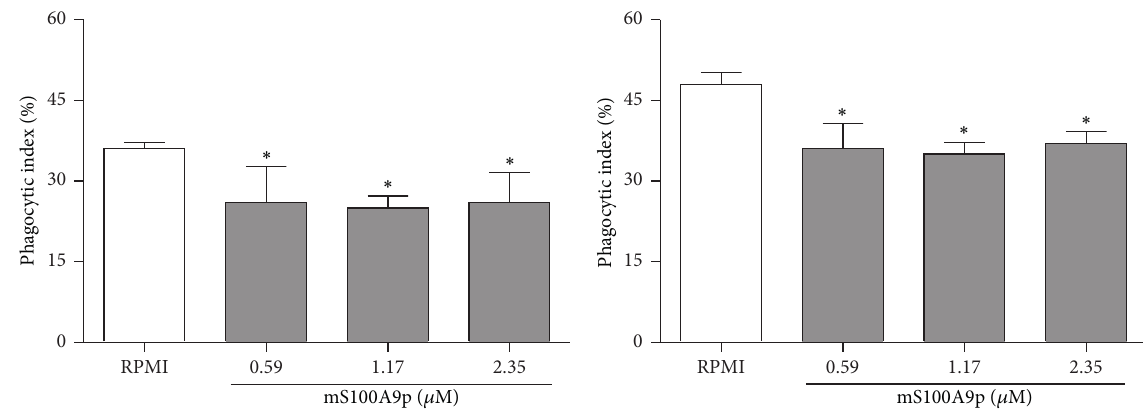
Figure 3: Phagocytosis assays by bone marrow-derived macrophages (BMDM 𝜙 ), cocultivated with B-1 cells, treated with mS100A9p. BMDM 𝜙 adhered to coverslips (1 × 10 5 cells/well) were incubated in the presence of B-1 cells (1 × 10 5 cells/well) concomitant with mS100A9p (0.59; 1.17; or 2.35 𝜇 M in RPMI-1640 medium), for 1h at 37 ∘ C in 5% CO 2 . Coculture assays were evaluated with (a) or without (b) direct contact of these two cell populations, using transwell chambers. Experimental controls were cocultures of BMDM 𝜙 and B-1 cells incubated only with culture medium. After 1h, both cocultures were incubated with 1 × 10 6 Candida albicans particles for 1h. Results are expressed as means ± SD, using five samples per group. ∗ 𝑃 ≤ 0.05, when compared to the control group